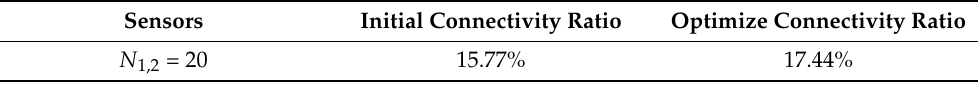
Table 18. Comparison of HWSN obstacle connectivity optimization experimental